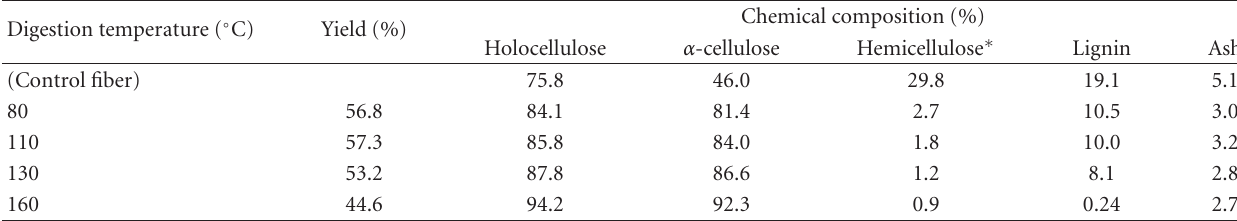
Table 1: Yields and chemical compositions of the digested fibers.